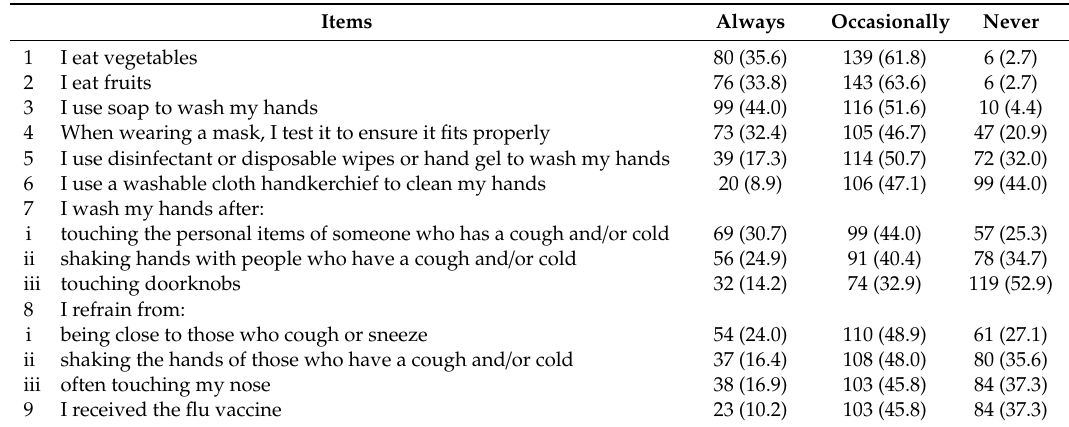
Table 4. Practice related to RTI